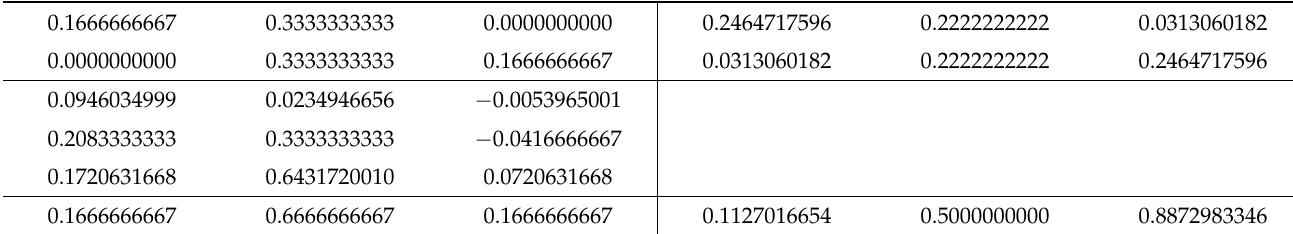
Table A26. eL3|G3 method.